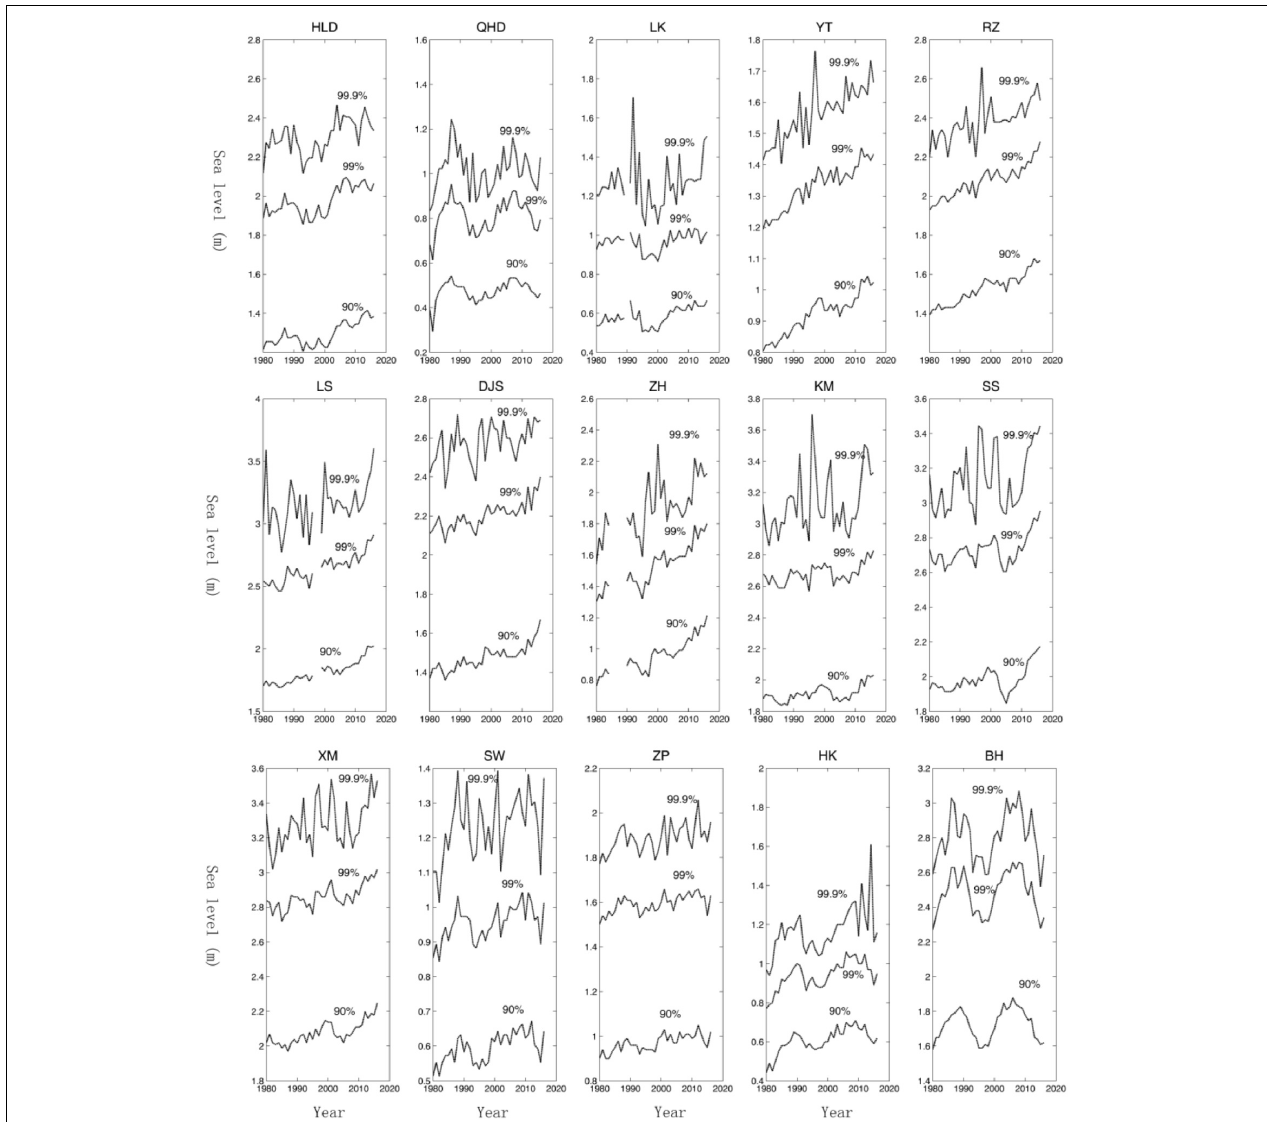
FIGURE 3 | 99.9, 99, and 90% values of the observed sea level at 15 tide